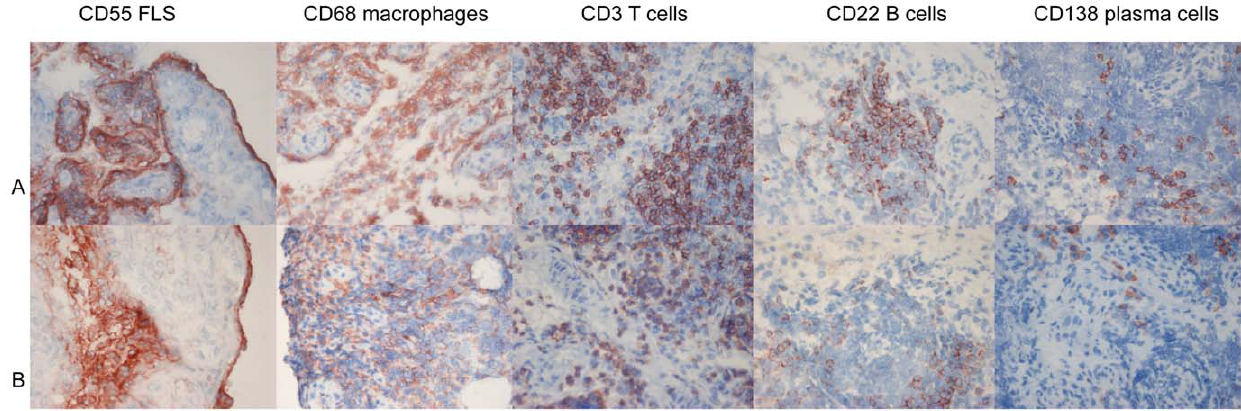
Figure 2. Synovial tissue expression of different cellular markers. Synovial tissue expression of, CD55 + fibroblast-like synoviocytes (FLS), CD3 + T CD68 + macrophages, CD3 + T cells, CD22 + B cells, CD138 + plasma cells. A:RA patient according to the 1987 ACR criteria, B:RA patient according to the 2010 ACR/EULAR criteria. doi:10.1371/journal.pone.0036668.g002 PLoS ONE |